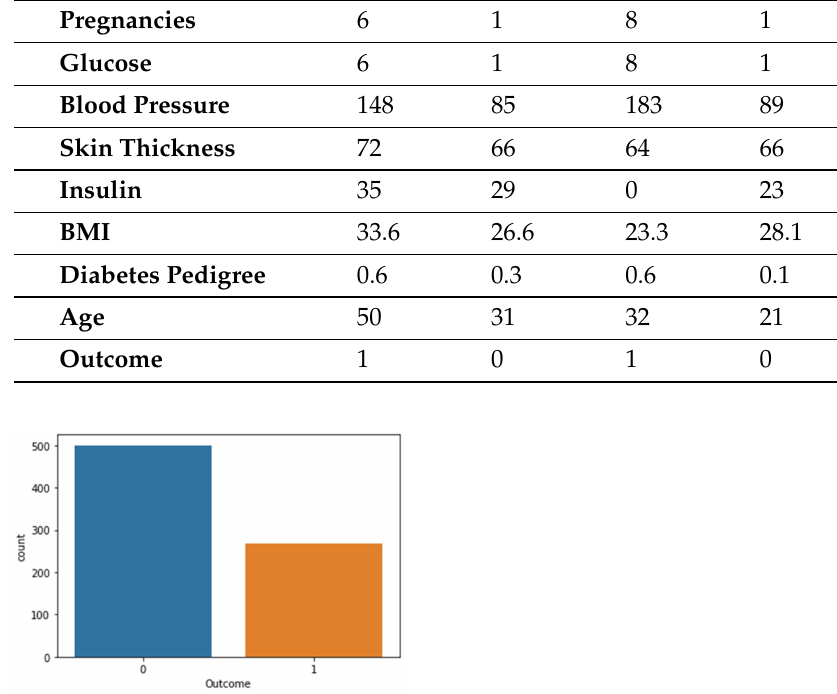
Figure 5. The total outcome of diabetic and non-diabetic patients.